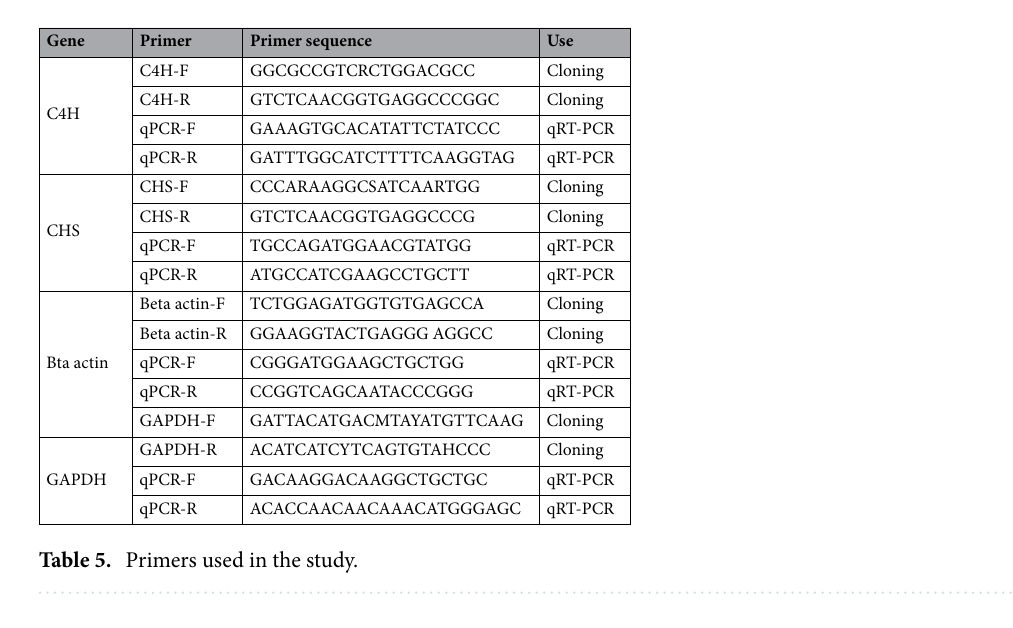
Figure 9. Results obtained from sequencing alignment by Clustalw method and primer design of protected regions in sequences used for the CHS gene.